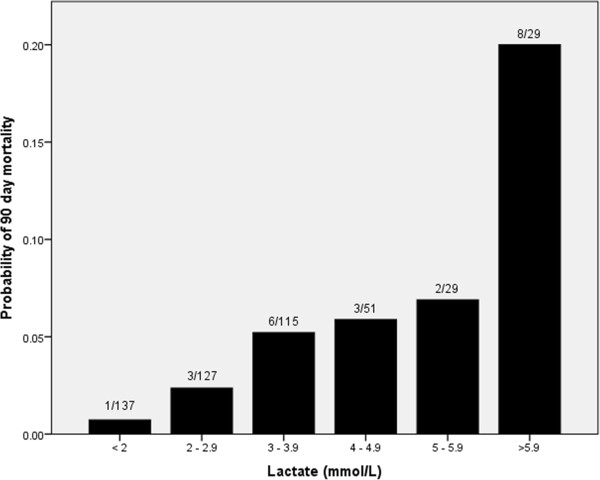
Probability of 90-day mortality after liver resection according to lactate concentration in 488 patients.